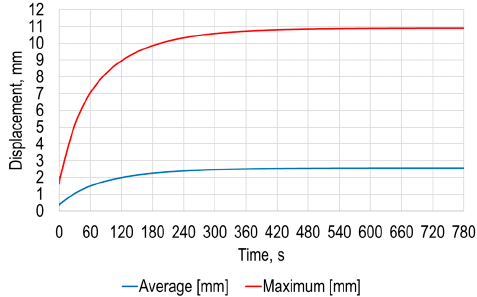
Figure 6. Average and maximum deformation under the earth gravity versus time of the polymer sheet.